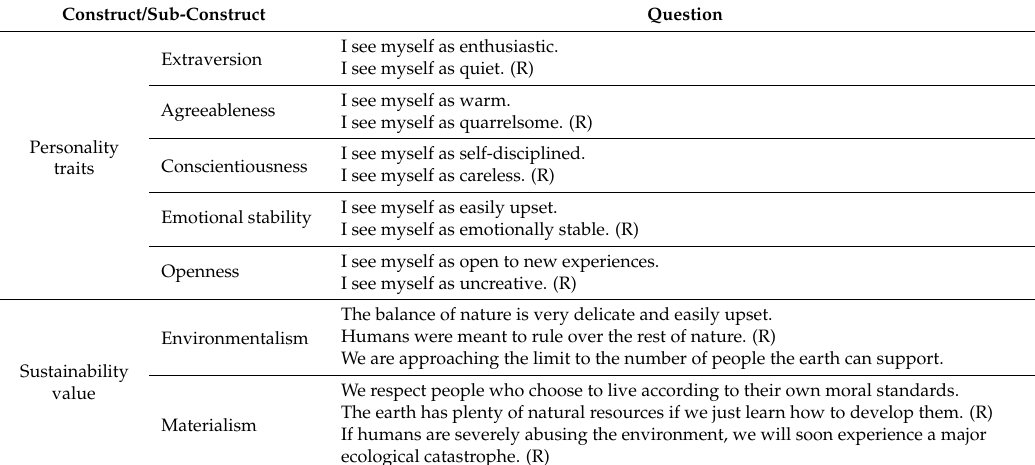
Table A1. Questions assessing perceived risk and pro-environmental behavioral